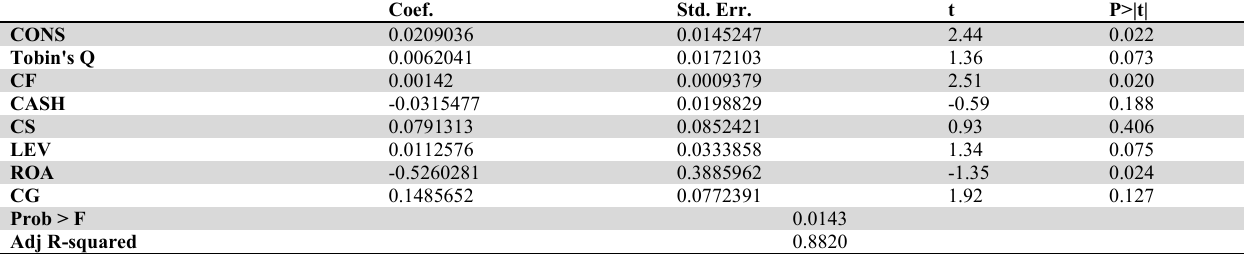
Regression results between conservatism and investment